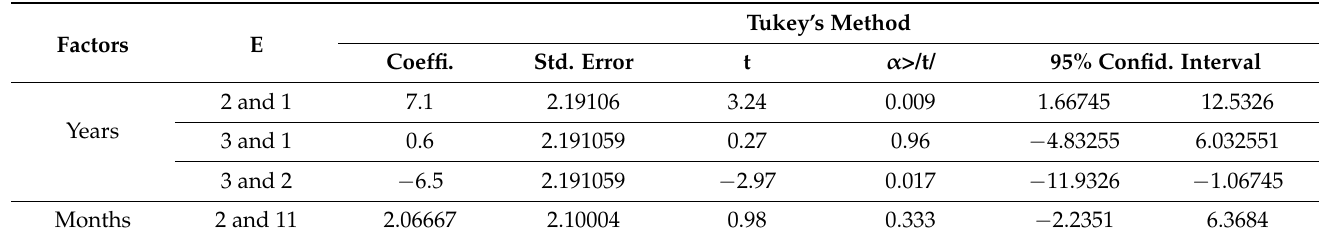
Table 2. Pairwise comparisons of the mean of Young’s moduli for the Injibara